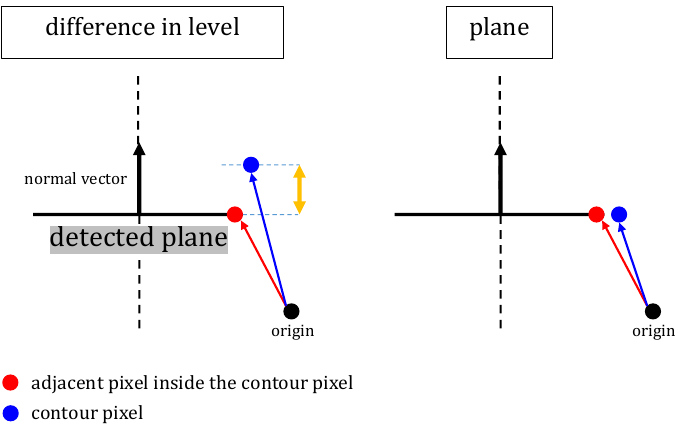
Figure 3. Illustration of the method to distinguish between a difference in level and a flat surface.